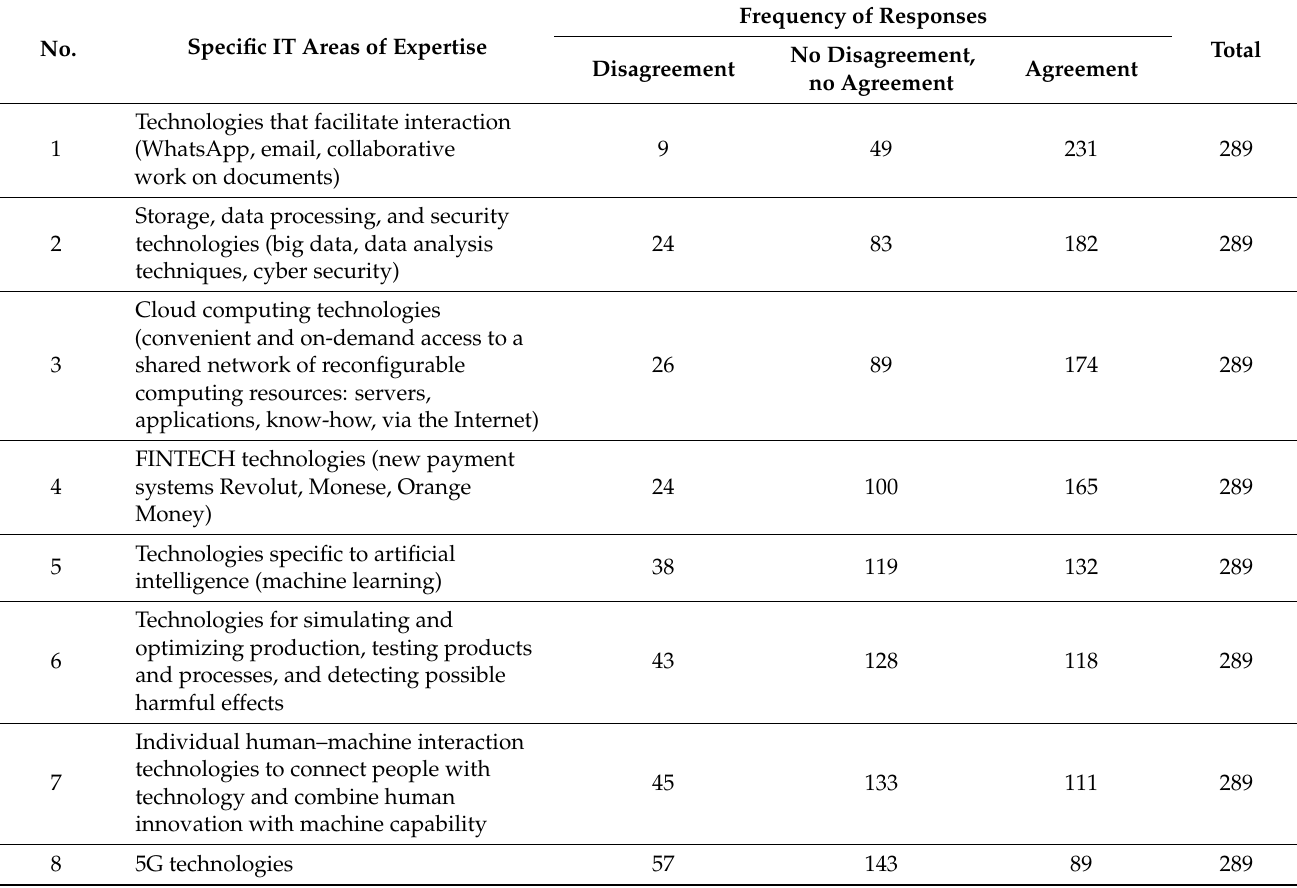
Table 18. Frequency by category of responses on specific areas of IT